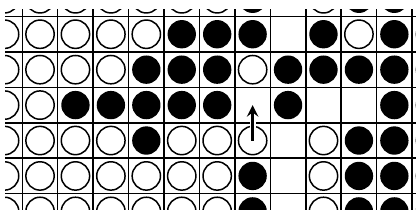
Figure 78. BLACK captures.